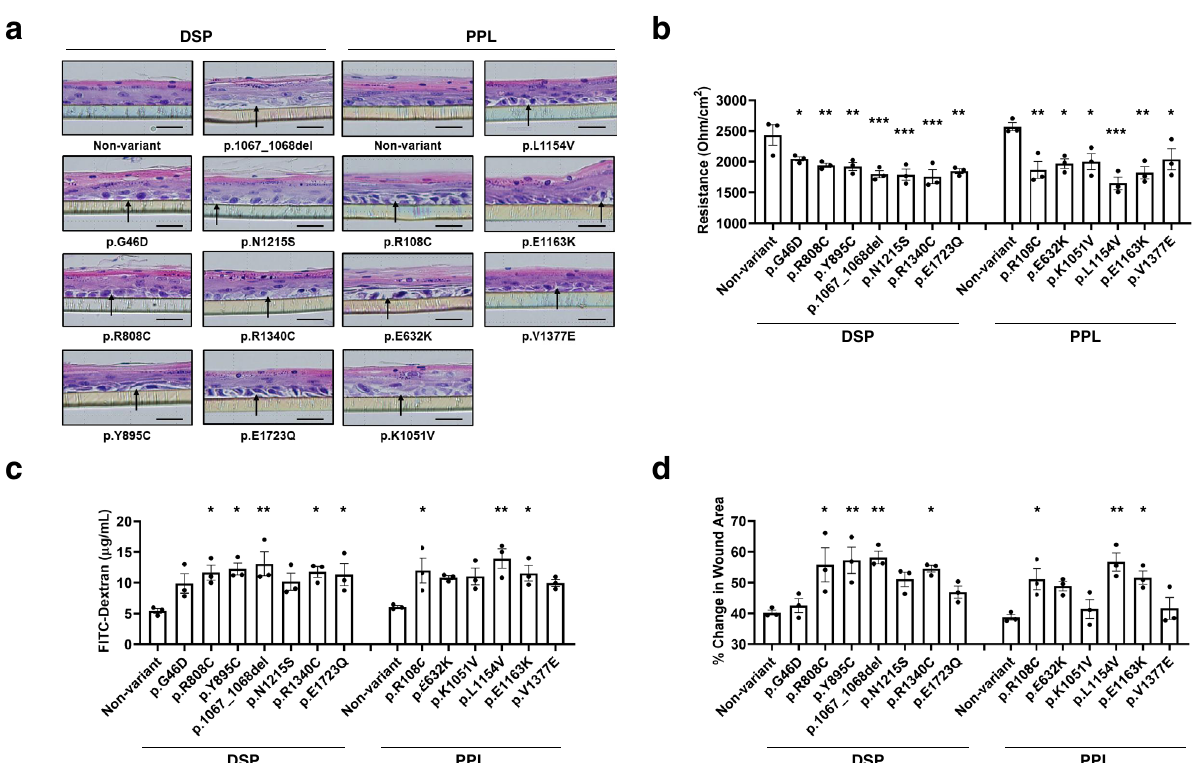
Fig. 3 Effects of EoE-associated DSP and PPL variants. a Representative hematoxylin and eosin (H&E) – stained sections of EPC2 cells stably transduced with constructs encoding non-variant and mutated DSP or PPL after air – liquid interface (ALI) differentiation (day 14). Arrows point to the non-cellular areas that were formed. Scale bar: 50 μ M. Data are representative of three experiments performed in duplicate. b The transepithelial electrical resistance (TEER) and c FITC-dextran fl ux measurements are shown for EPC2 cells grown at the ALI. d Wound healing assays performed in EPC2 cells transduced with constructs encoding non-variant and mutated DSP or PPL . Quanti fi cation of the wound closure after 8 h was shown. For panels b – d data are representative of three experiments performed in duplicate and are presented as mean ± SEM. Statistics (versus non-variants): b (p.G46D, P = 0.0324; p.R808C, P = 0.0059; p.Y895C, P = 0.0042; p.1067_1068del, P = 0.0006; p.N1215S, P = 0.0005; p.R1340C, P = 0.0003; p.E1723Q, P = 0.0012; p.R108C, P = 0.0041; p.E632K, P = 0.0131; p.K1051V, P = 0.0189; p.L1154V, P = 0.0004; p.E1163K, P = 0.0024; p.V1377E, P = 0.0291), c (p.G46D, P = 0.1542;